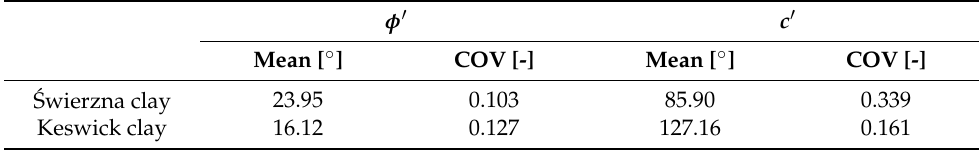
Table 7. Variability measures of parameters according to the MoE.